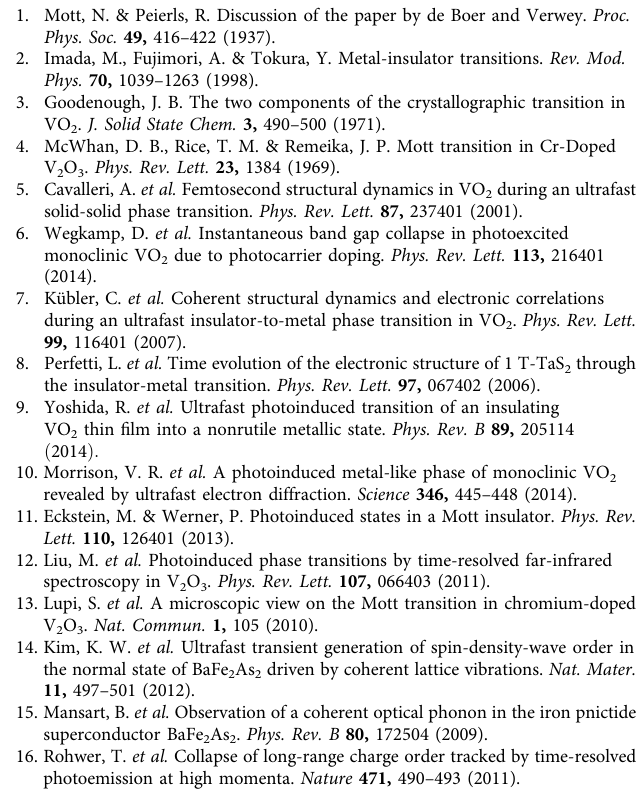
Figure 4 | Theoretical calculations. ( a ) Hatree–Fock total energy as function of the occupancy difference between e p is 2). ( b ) DOS for different occupancies of the a 1 g . ( c ) Schematic view of the proposed mechanism involved in the photoexcitation of a Mott material, where the a 1 g states lower in energy both of the PM and PI